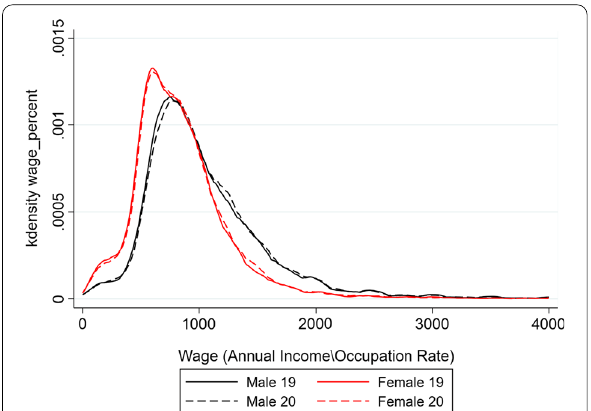
Fig. 9 Wage distribution by gender and year. Notes This figure plots kernel density of the wage distribution of men and women in 2019 and 2020. Wage is measured by dividing income by the occupation rate. The black line is for men and red line is for women. The solid and dashed lines correspond to the data in 2019 and 2020, respectively